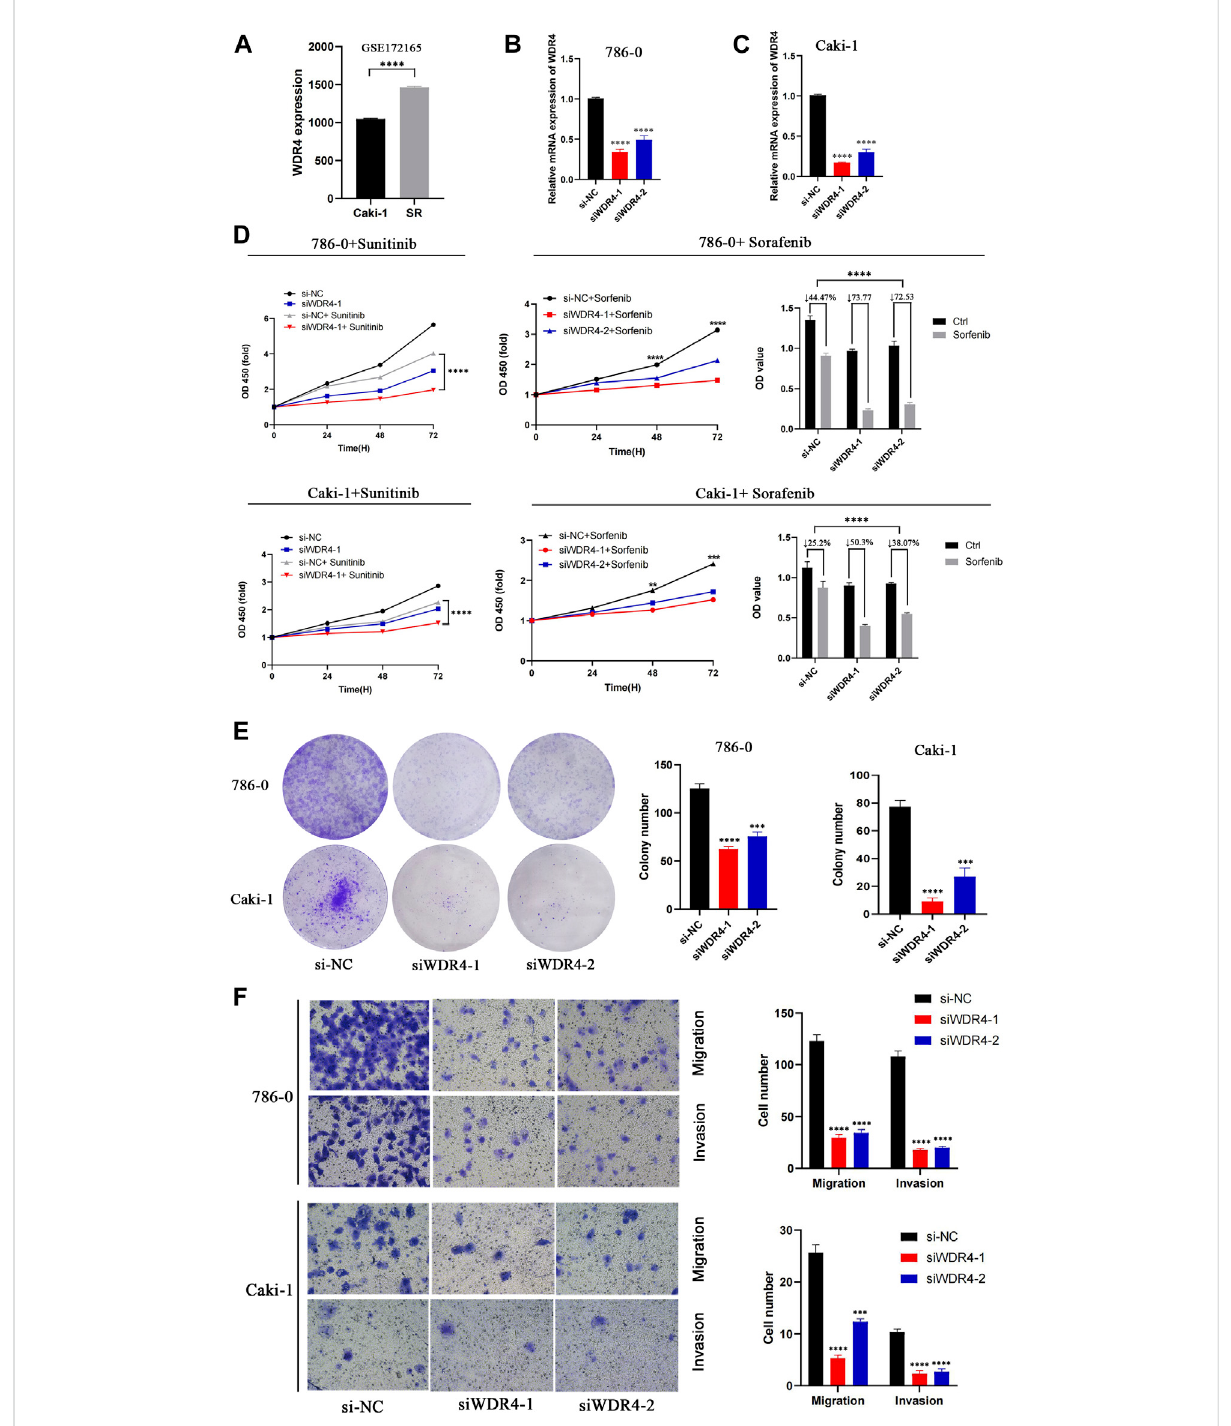
FIGURE 9 Effects of WDR4 on the biological function and drug resistance of KIRC cells. (A) Expression of WDR4 in sunitinib-resistant cell lines. (B – C) Detection of WDR4 knockdown ef fi ciency. (D) Effects of WDR4 knockdown on KIRC cell proliferation and drug sensitivity. (E) Effect of WDR4 knockdown on the colony formation ability of KIRC cells. (F) Effects of knockdown of WDR4 on the migration and invasion of KIRC cells. SR: